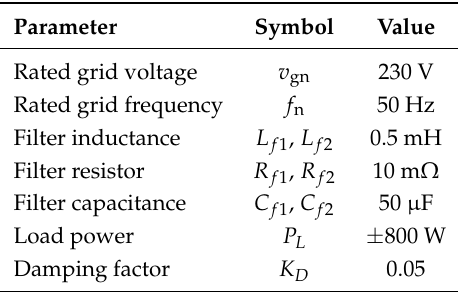
Table 1. AC microgrid simulation